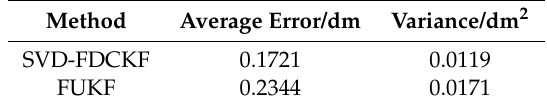
Figure 11. The error between the positioning result estimated by FUKF, SVD-FDCKF, and the actual position. Table 4. The average error and variance of SVD-FDCKF and